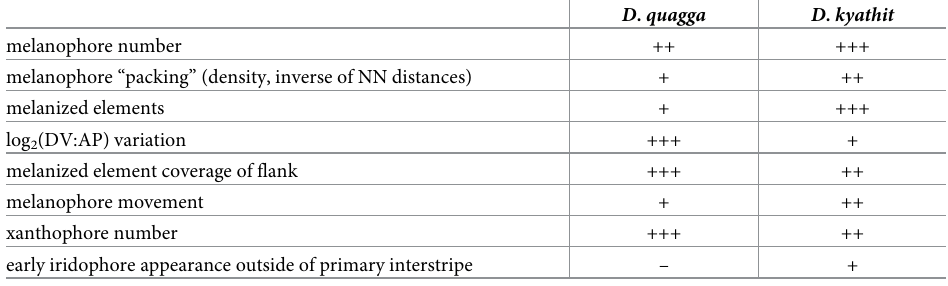
Table 1. Qualitative summary of phenotypes. Interpretations derived from numerical and statistical analyses in Figs 4, S3, S4, S6 and S1